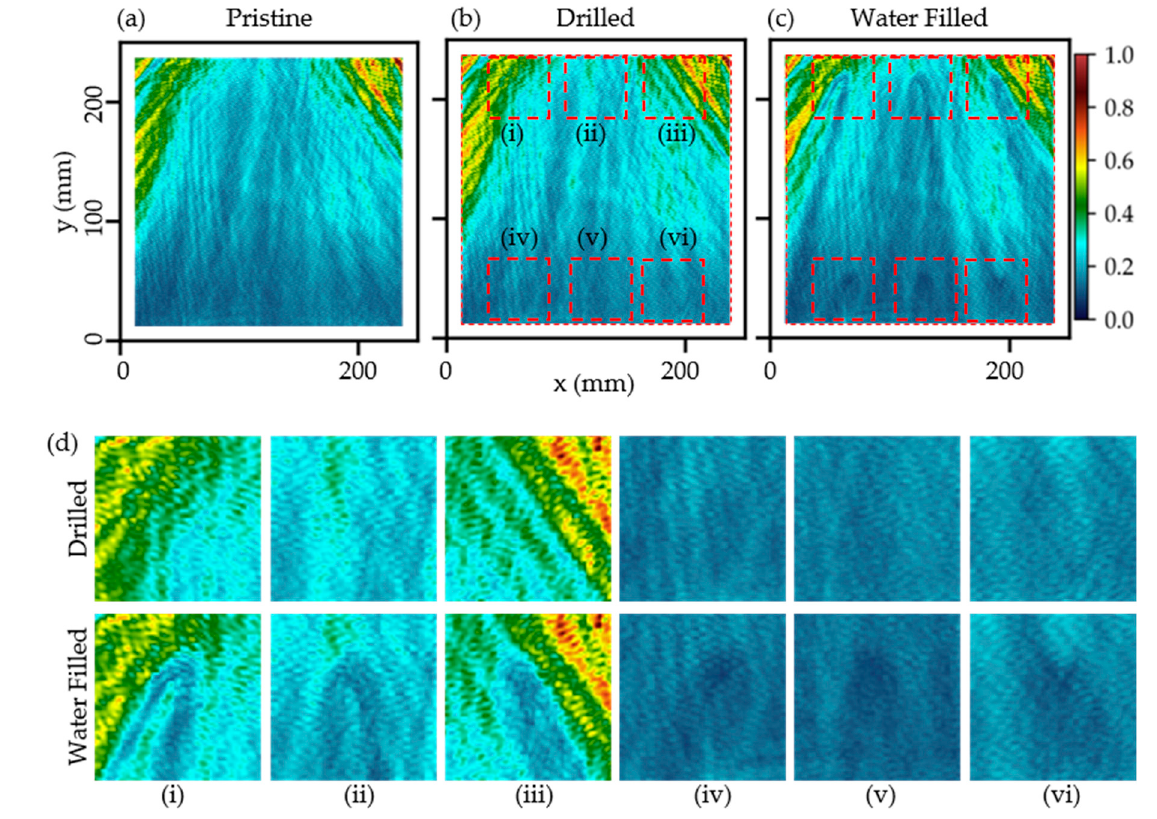
Figure 12. Spectral energy maps of Case D3, generated from the A0 -isolated data at the ( a ) pristine state, ( b ) after drilling the water-injecting holes, and ( c ) after filling the cells with water. ( d ) Zoom-in views for regions ( i )–( vi ) are given for easier comparisons.